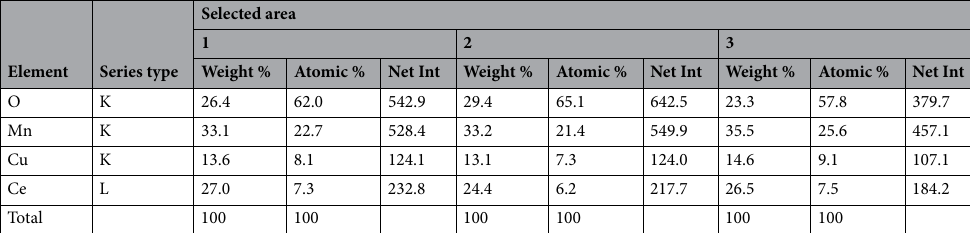
Table 1. EDS data of three selected areas of